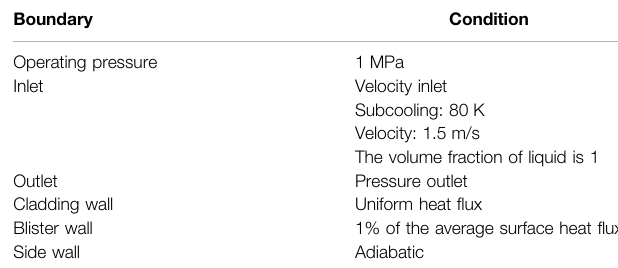
TABLE 1 | The boundary conditions for deformation